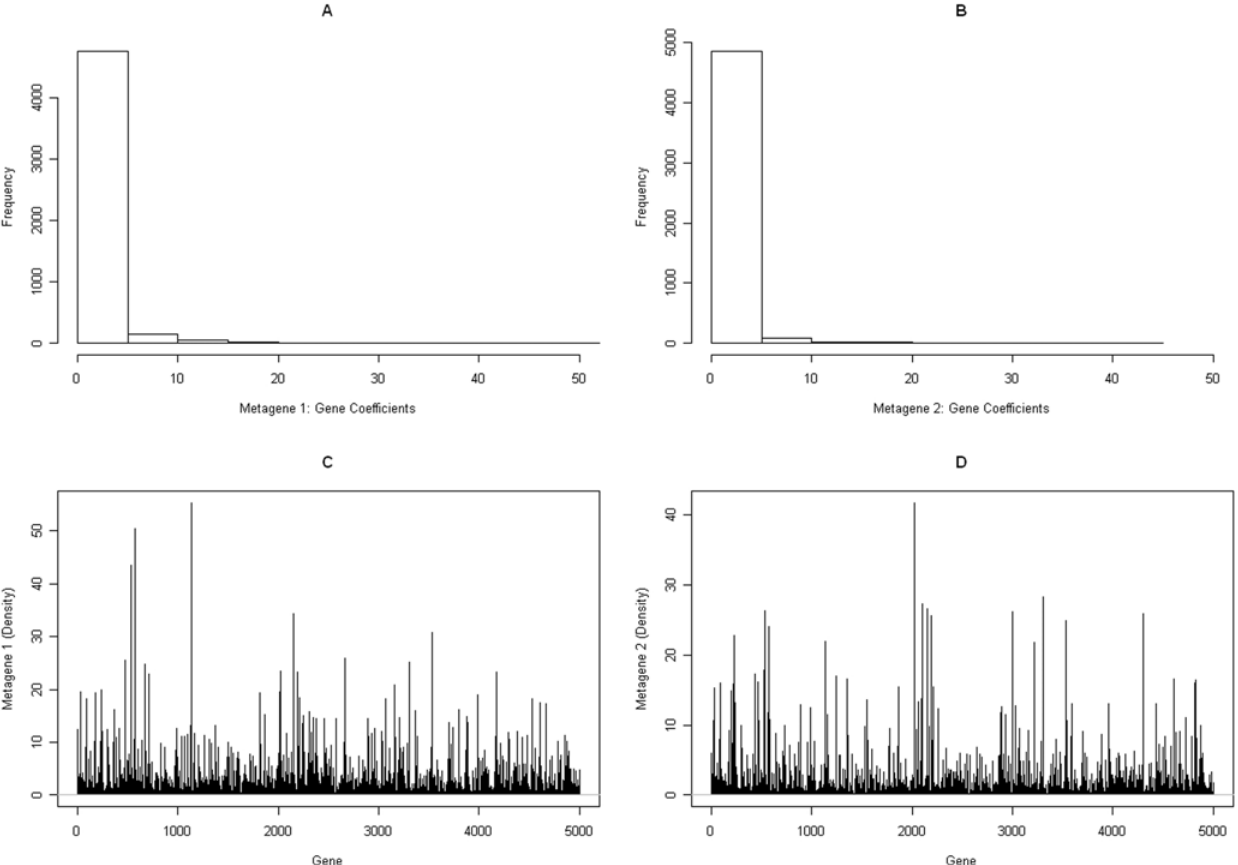
Figure 1. Gene coefficients. (A) Histogram of gene coefficients, metagene 1. (B) Histogram of gene coefficients, metagene 2. (C) Density of gene coefficients, metagene 1. (D) Density of gene coefficients, metagene 2.